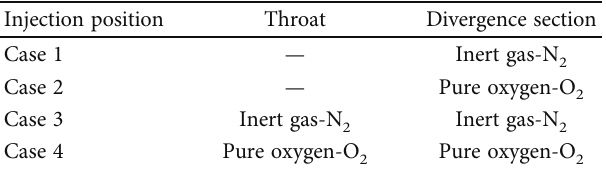
Table 3: Injection schemes of